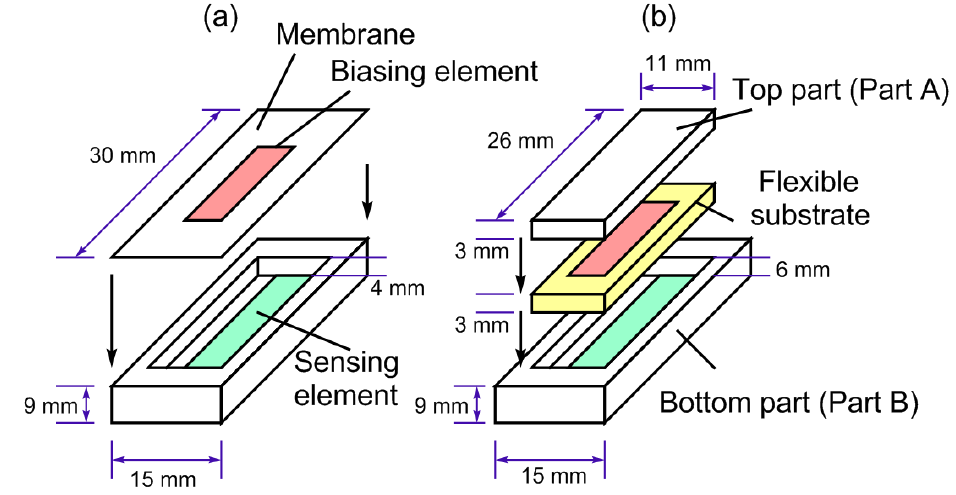
Figure 2. (a) The design of the magnetic harmonic pressure sensor. The biasing element was embedded on a flexible membrane and the sensing element was on a rigid substrate. (b) The design of the magnetic harmonic strain/stress sensor. The biasing and sensing elements were separated by a flexible substrate, and the whole structure was encased within two plastic